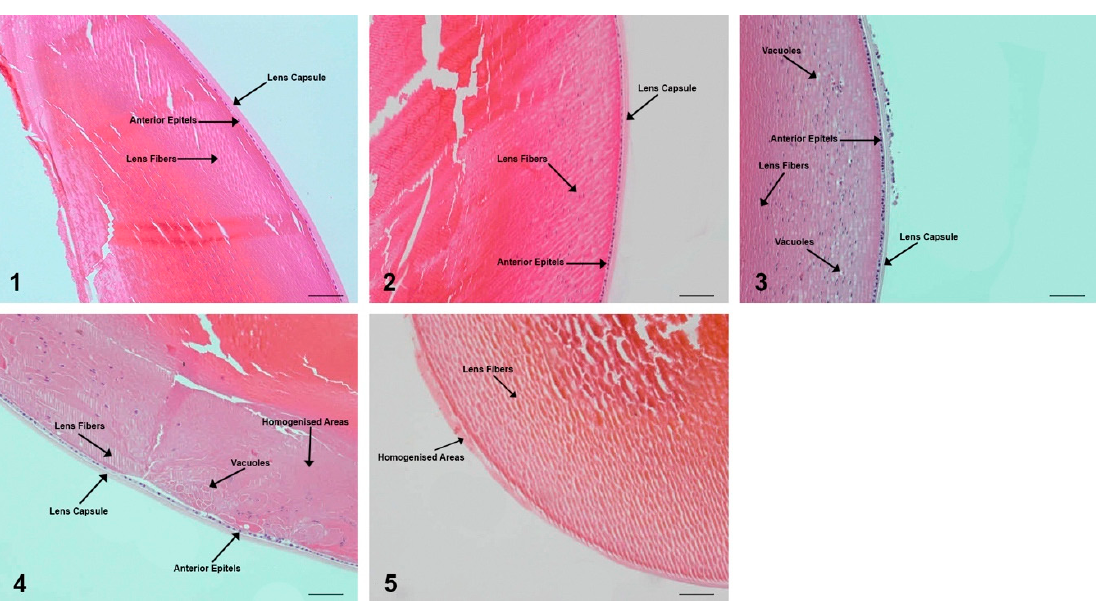
Grade 3: Absence of anterior epithelium, presence of lens fibers, vacuoles, homogenized area; Grade 4: Presence of lens fibers and homogenized area only.